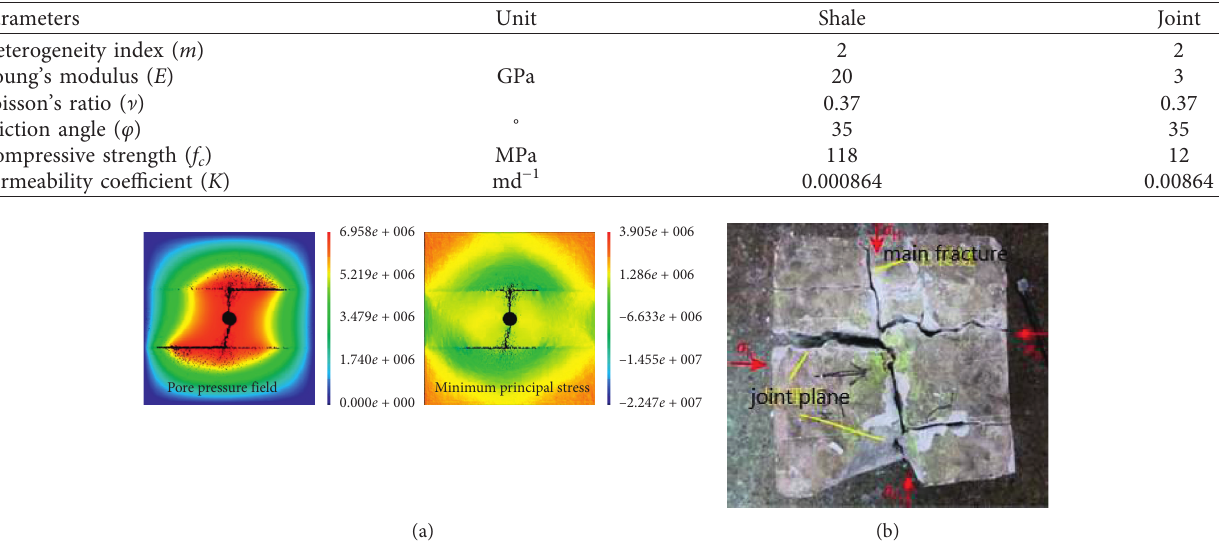
Figure 11: Fracture evolution in the numerical and experimental results [36] of the jointed shale model. (a) Numerical results. (b) Experimental